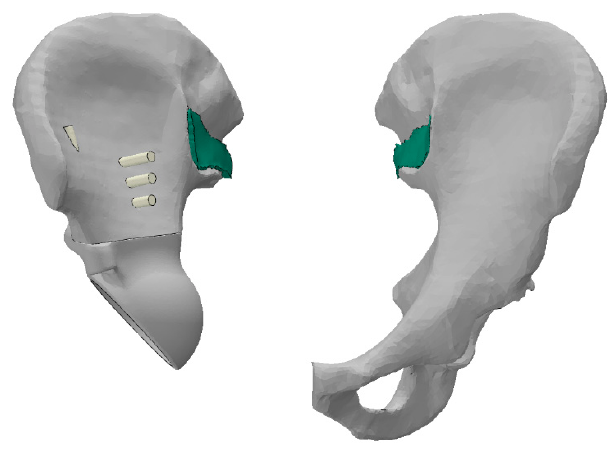
Figure 9. Finite element model of implant.